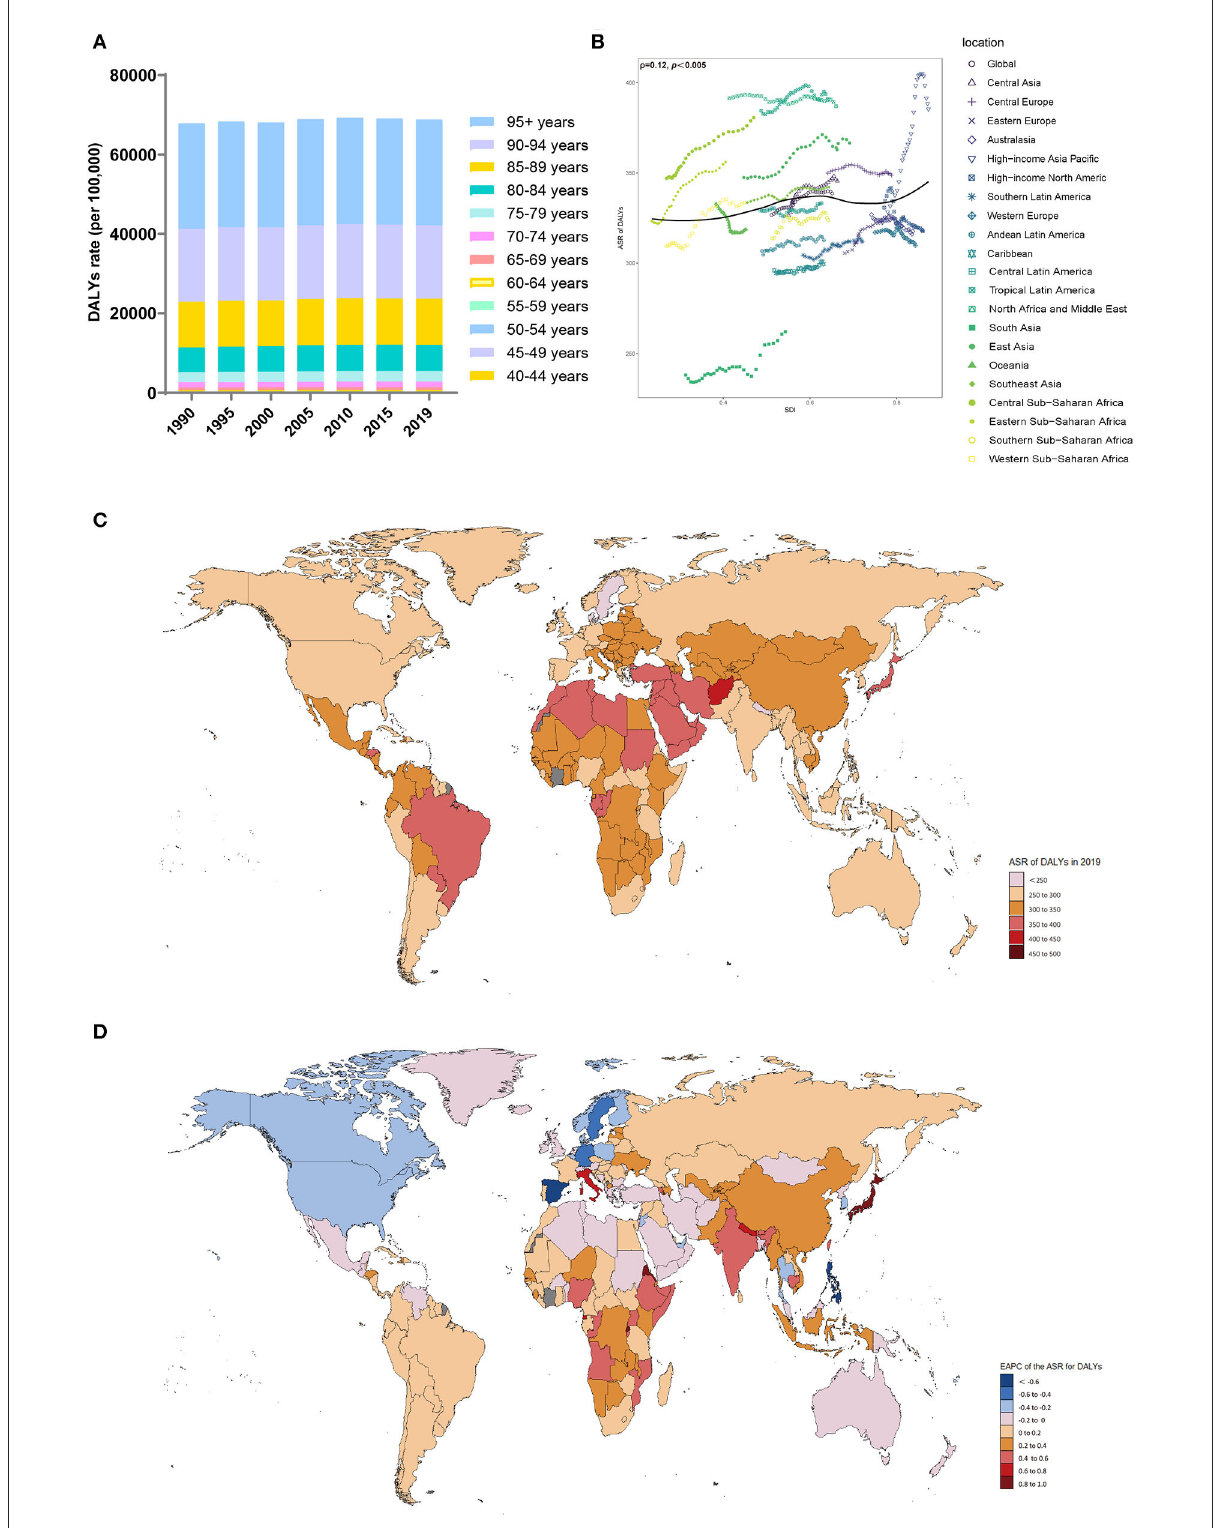
FIGURE4 Distribution of DALYs due to Alzheimer’s disease and other dementias in 204 countries and territories from 1990 to 2019 by age group and SDI region. (A) DALYs rate in each age group; (B) Correlations between the ASR of DALYs due to Alzheimer’s disease and other dementias and SDI regions in 2019; associations were calculated with Pearson correlation analysis; (C) ASR of DALYs of 204 countries and territories; (D) EAPCs in the ASR of DALYs in 204 countries and territories. DALYs, disability-adjusted life-years; SDI, sociodemographic index; ASR, age-standardized rate; EAPC, estimated annual percent